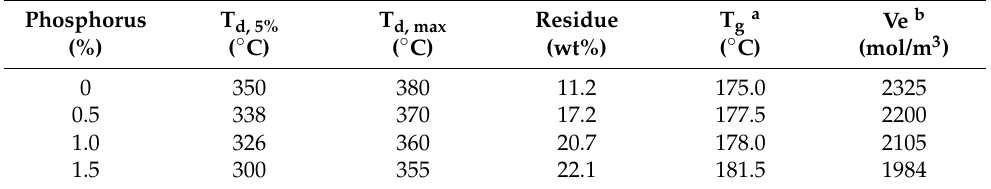
Figure 8. TGA ( a ) and DTG ( b ) curves of different resin systems in N 2 . Table 4. TGA and thermomechanical data.